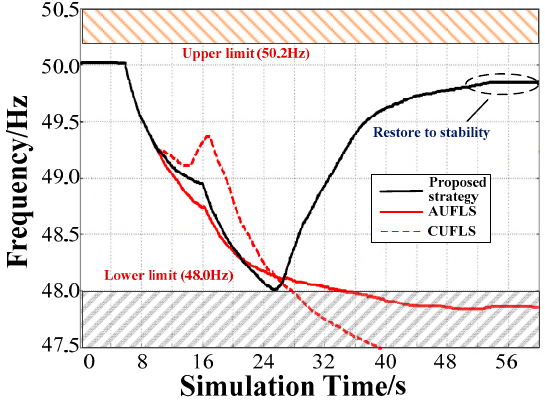
Figure 9. The frequency recovery process of each strategy under scenario-4.